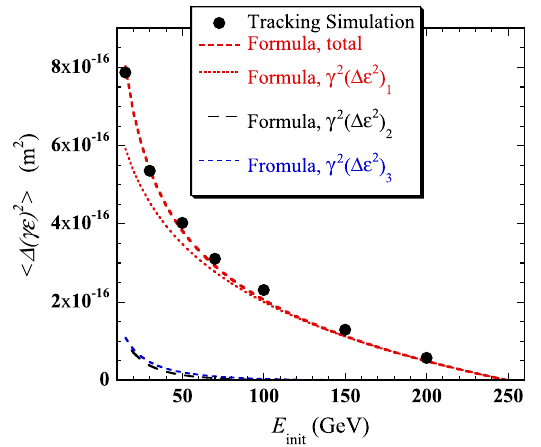
FIG. 3. Average growth of square of emittance ( hð (cid:4)(cid:3) Þ 2 i ) at the linac end, with BPM offset error 50 (cid:10) m (rms) after one to one of ð (cid:2) (cid:3) 2 Þ , ð (cid:2) (cid:3) 2 Þ , correction, as a function of the initial beam energy for the 1 2 E downstream part of the ILC main linac. Results of tracking simulation (circle), and the analytic formula. Contributions of ð (cid:2) (cid:3) 2 Þ , ð (cid:2) (cid:3) 2 Þ , and ð (cid:2) (cid:3) 2 Þ are also shown. 1 2 3